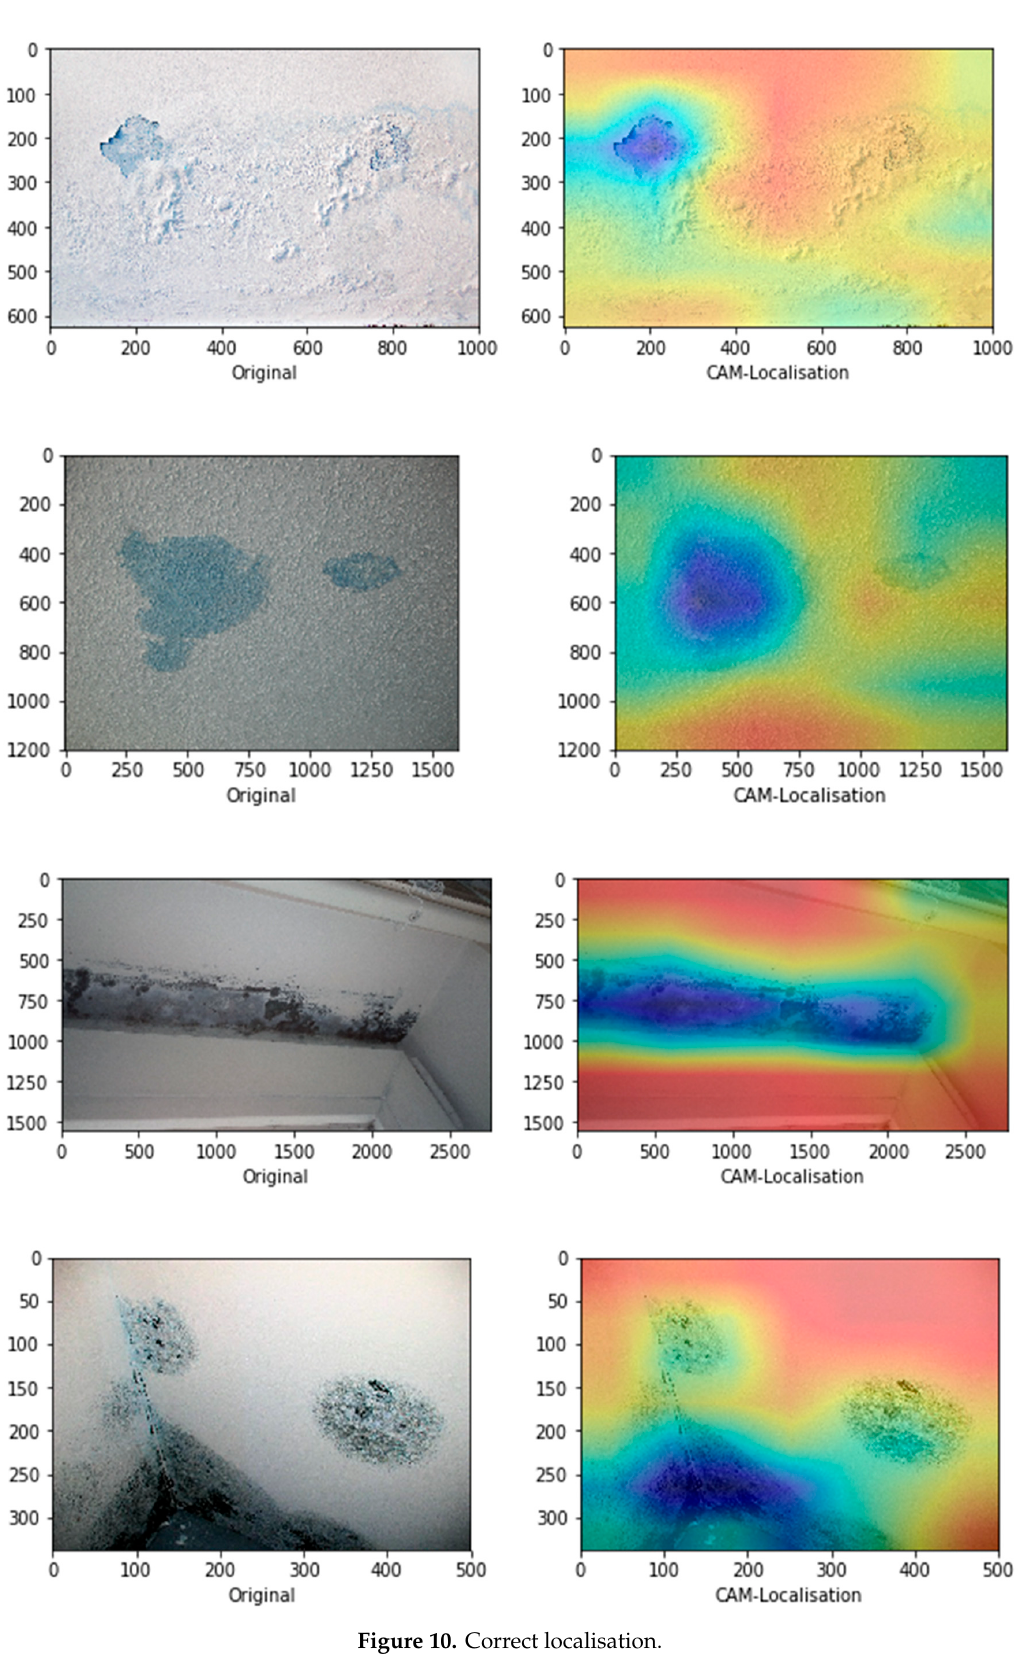
Figure 10. Correct Figure 10. Correct localisation.